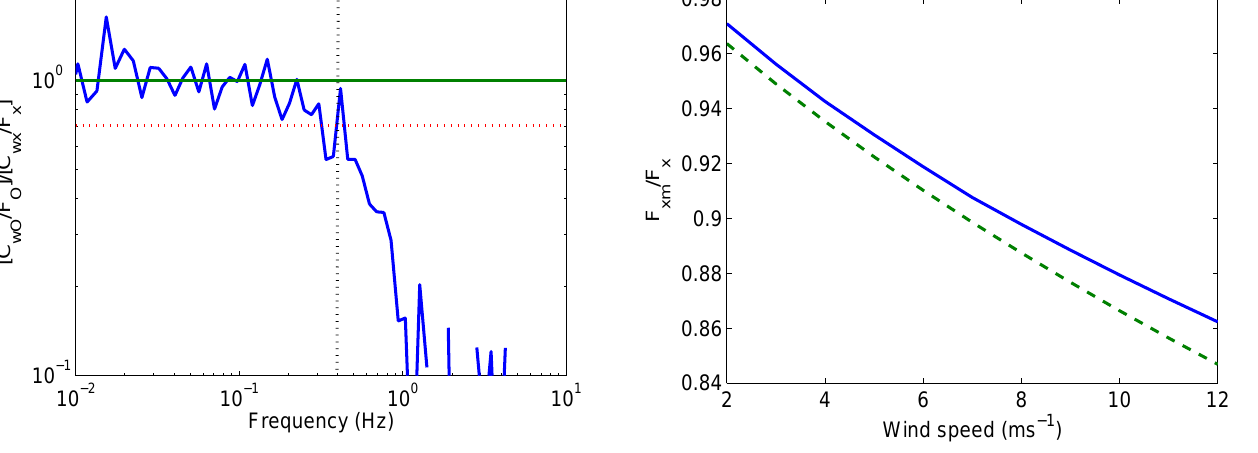
Fig. 9. Ratio of normalized cospectra from Fig. 8. The horizontal Fig. 10. Relative wind speed dependence of the ozone sample tube √ dotted line indicates a ratio of 1 / 2, and the vertical dashed line smoothing correction assuming τ c = 0 . 4s for the experimental set shows a cutoff frequency of 0.4Hz. up on the NOAA Ship Ronald H. Brown ( z =18m). The solid line represents the Kaimal model and the dashed line is the expression from Horst